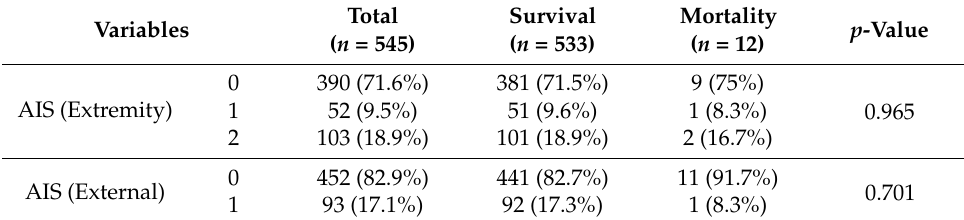
Table 2. Continuous variables of patient age, injury characteristic, physiological response, and laboratory data. BMI: body mass index; HR: heart rate; SBP: systolic blood pressure; RR: respiratory rate; GCS: Glasgow Coma Score; ISS: Injury Severity Score; RBC: red blood cell; WBC: white